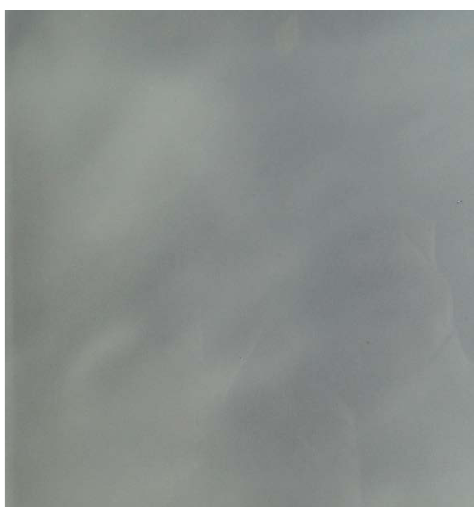
Fig. 16 Sample with the film 3 and paint sprayed on the glass after the aging process